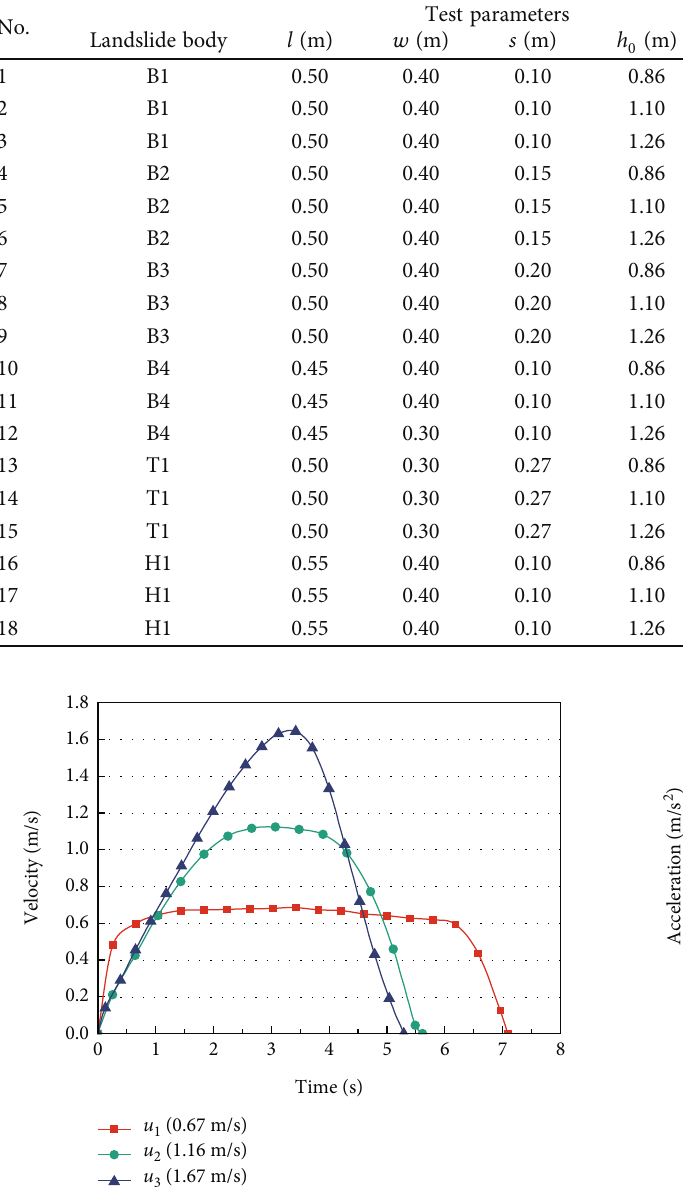
Table 1: Experimental design and test results.